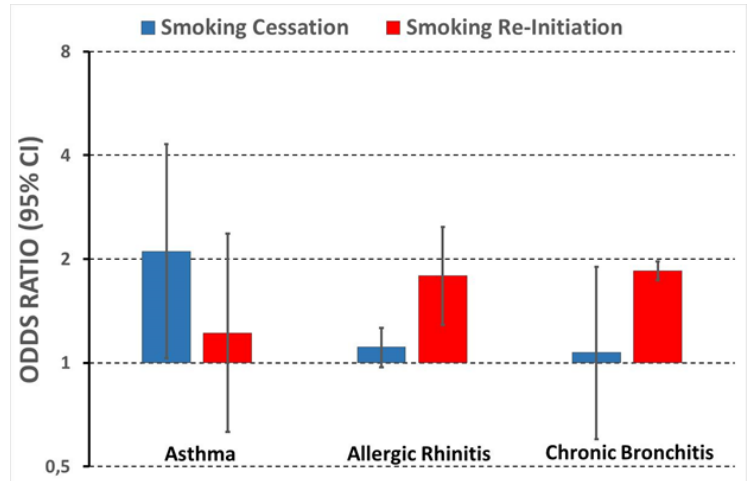
Figure 1. The Odds Ratio (OR) of smoking cessation and re-initiation as a function of respiratory disorders, investigated among current smokers and ex-smokers at baseline, respectively. ORs of smoking cessation and related p- values were obtained by a logistic model, controlling for centre, sex, age, number of cigarettes smoked daily, and age of smoking initiation. When investigating smoking re-initiation, age at smoking initiation was replaced in the logistic model by years of smoking abstinence until baseline. Table 3. Influence of socio-demographic characteristics, respiratory disorders, smoking intensity, and age at smoking initiation on smoking cessation.